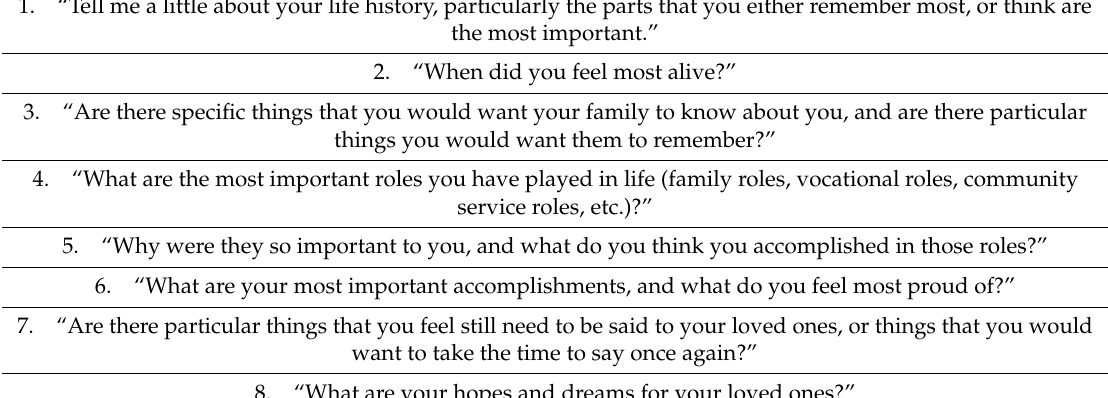
Table 1. Questions of Dignity